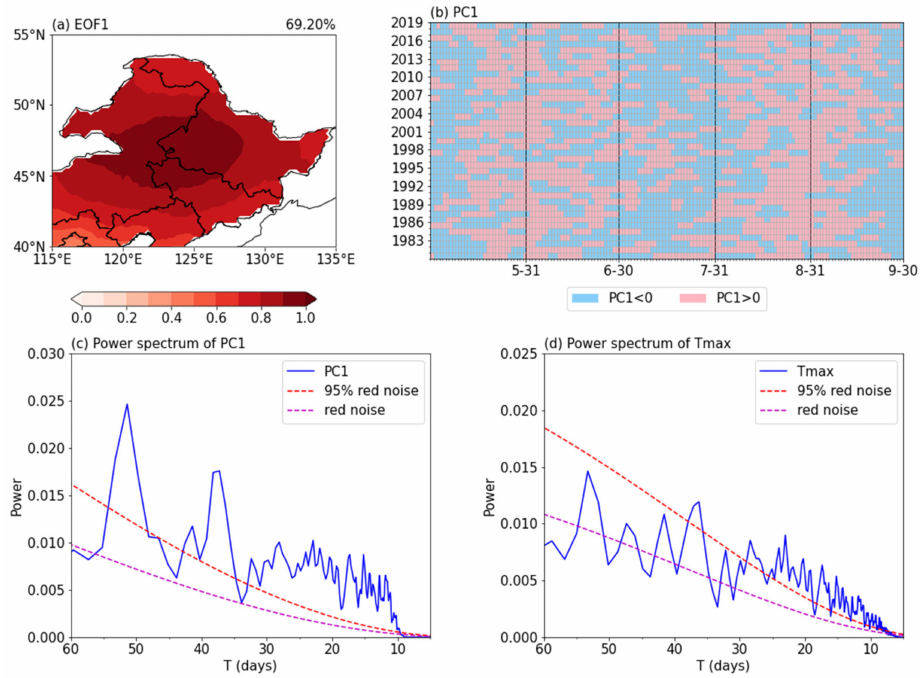
Figure 1. The first EOF mode of the 10–90 d oscillation component of daily Tmax subtracting thresholds from 1 May to 30 September during 1981–2019 ( a ) and its corresponding time coefficient PC1 ( b ), power spectrums of PC1 ( c ), and daily Tmax in northeast China after removing its seasonal cycle and synoptic signal ( d